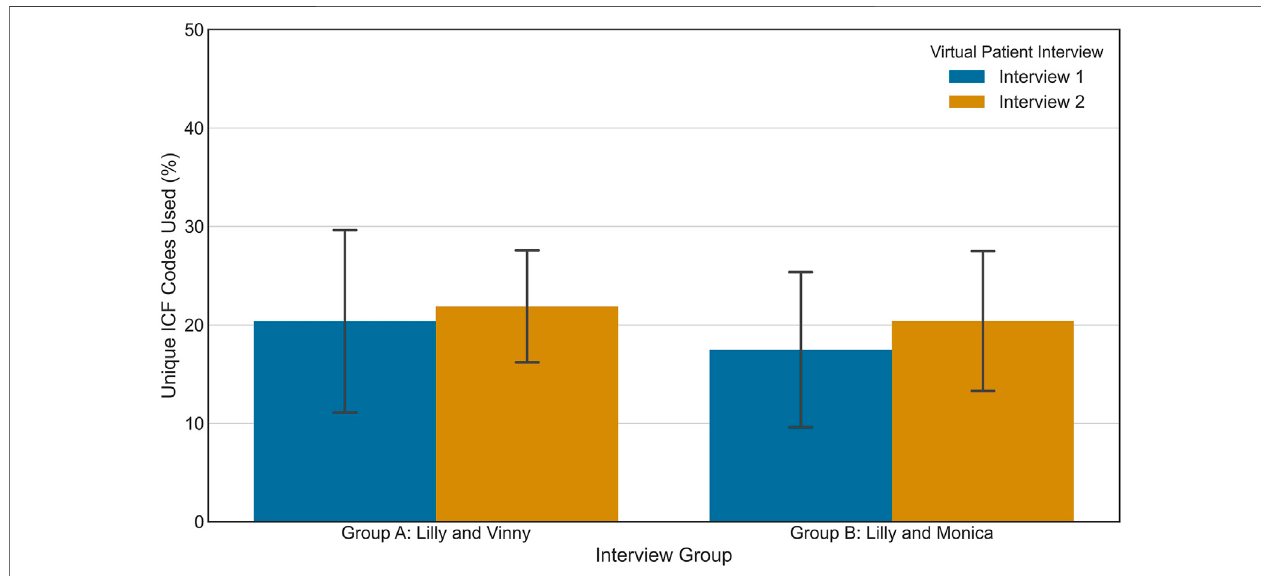
FIGURE 3 | The means and standard deviations of unique ICF codes used for students in the Message Production Trends study.